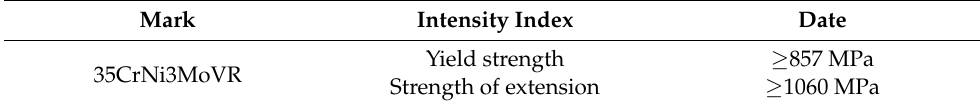
Table 4. Mechanical properties of 35CrNi3MoVR at 150 ◦